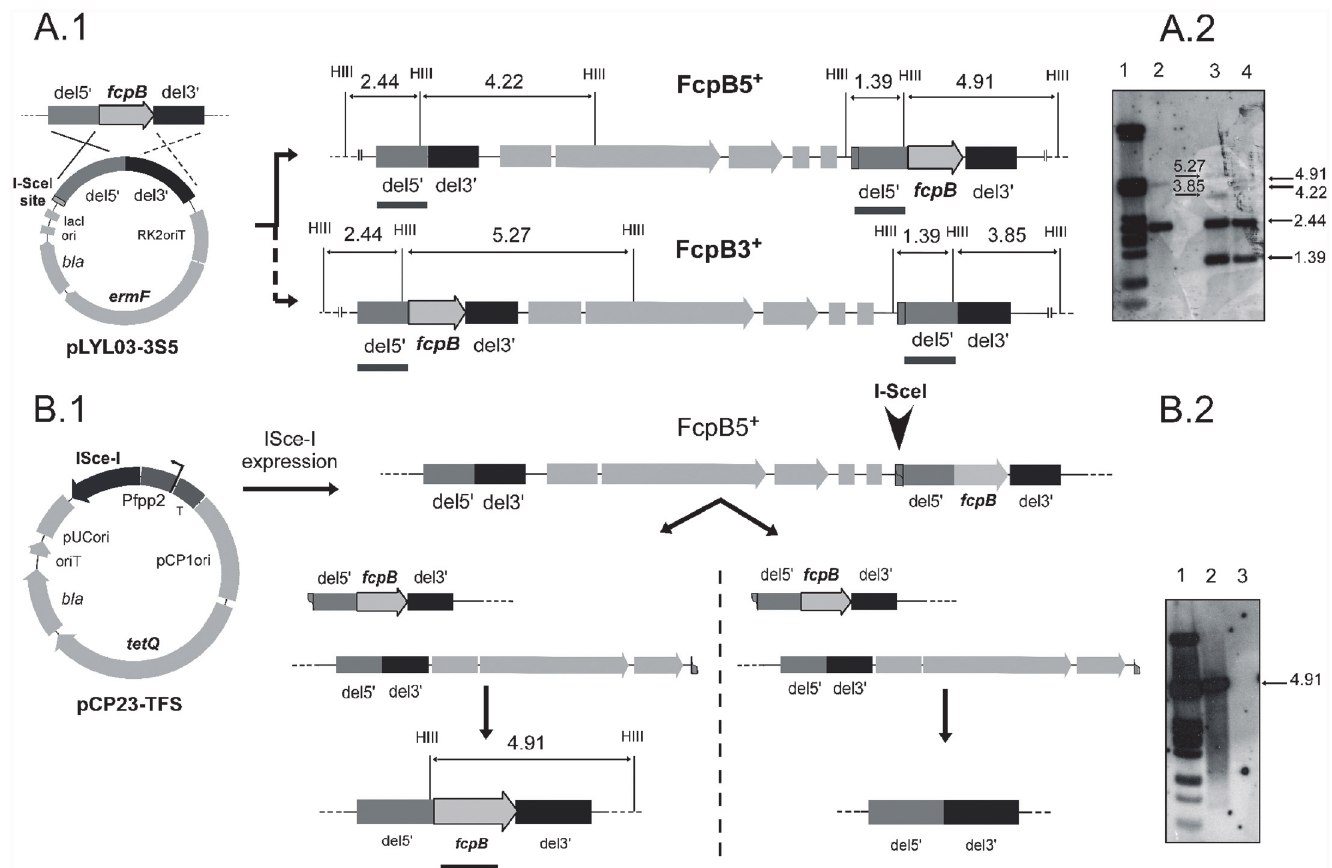
Fig 2. Markerless deletion strategy for F. psychrophilum . (A1) A suicide plasmid (pLY03 – 3S5), containing an I- Sce I recognition site and two fcpB flanking sequences of 1.5 kb (del5 ’ and del3 ’ ), was introduced in F. psychrophilum THC02/90 by conjugation. RK2oriT: conjugal transfer origin; ermF : erythromycin resistance gene in F. psychrophilum ; bla : ampicillin resistance gene in E. coli ; ori: replication origin in E. coli ; lacI: lacI gene. Two possible integrations, depending on the flanking region where the recombination had occurred (FcpB5+ and FcpB3+ strains), are represented following continuous and dashed lines. Hind III restriction sites are indicated with HIII and the size of Southern Blot expected bands, using del5´ as a probe (grey line), are indicated above each scheme. (A2) Southern blot hybridization using a PCR generated labeled del5´ DNA fragment as a probe. Genomic DNA, from the parental strain F. psychrophilum THCO2/90 (lane 2) and the transconjugants which harbor the two possible generated cointegrates: lanes 3, FcpB3 + and lane 4, FcpB5 + , was digested with Hind III and hybridized with del5´ fragment labeled probe. Molecular mass ladder, phage λ DNA digested with Pst I (lane 1). The two top hybridization bands corresponding to lane 3 (5.27 and 3.85 kb) and lane 4 (4.91 and 4.22 kb) are tenuous because the length of their homologous sequences with the probe is very short. (B1) The FcpB5 + and FcpB3 + merodiploid strains were conjugated (only FcpB5 + is represented) with an E. coli S17 – 1 λ pir strain harboring a plasmid (pCP23-TFS) expressing I- Sce I (I-SceI) under the control of the F. psychrophilum fpp2 calcium-temperature inducible promoter (Pfpp2). T: transcription terminator; pCP1ori: replication origin in F. psychrophilum ; tetQ : tetracycline resistance gene in F. psychrophilum ; bla : ampicillin resistance gene in E. coli ; oriT: conjugal transfer origin; pUCori: replication origin in E. coli . Transconjugants were selected at 12°C in a medium containing tetracycline and CaCl 2 leading to the resolution of the merodiploid by generation of a wild-type genotype (left side of the figure) or in a markerless fcpB gene deleted strain (right side of the figure). I- Sce I mediated double strain break is indicated by an arrow head symbol. (B2) Southern Blot hybridization using genomic DNA from the wild-type and the fcpB deleted mutant strain, digested with Hind III and hybridized with an internal fcpB fragment. Lane 2, wild-type; lane 3 fcpB deleted mutant strain; Lane 1, molecular mass ladder (phage λ DNA digested with Pst I).